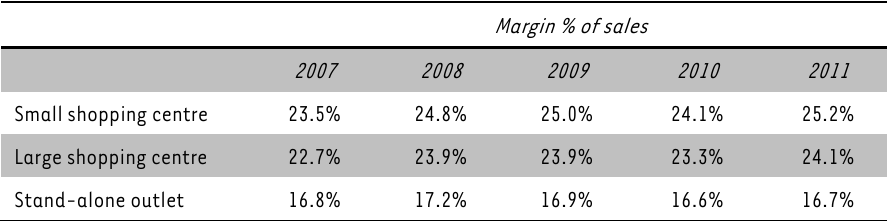
TABLE 10: Gross margin % by retail format